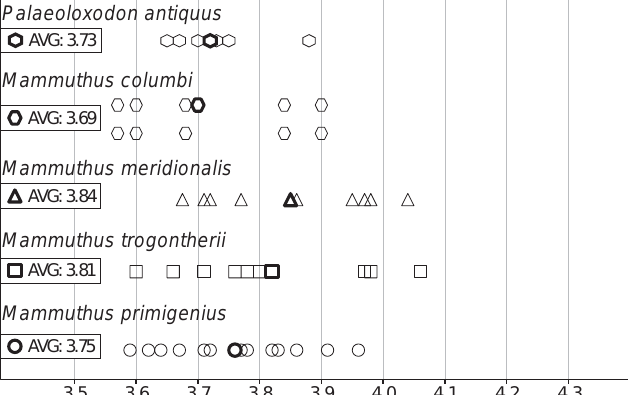
Fig. 5. Radius length vs. skeletal shoulder height ratio of selected probos- cideans based on the data collected in this study (Appendix 1, SOM: table 2; AL unpublished